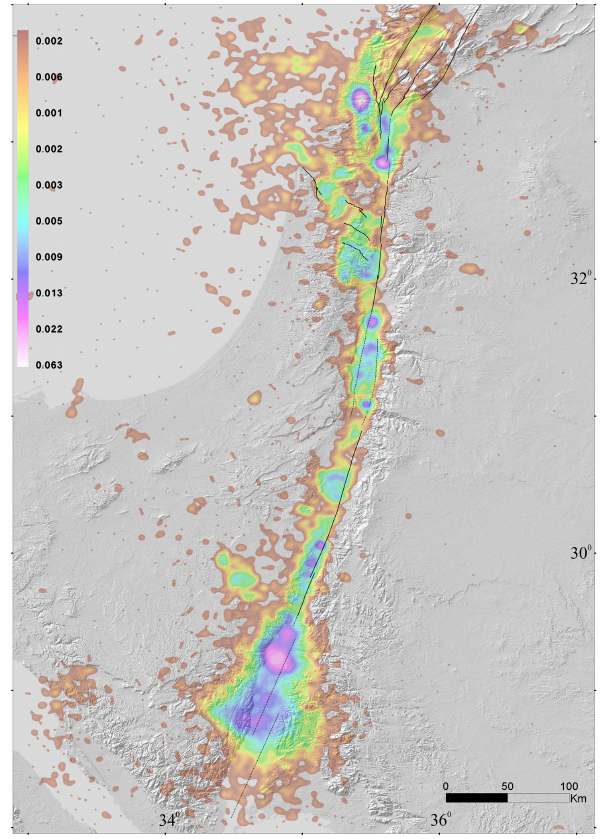
Figure 3. The earthquake kernel density distribution, accord- ing to the relocated catalogue. Colours and corresponding num- bers indicate the value in events per squared kilometre per year (eventskm − 2 yr − 1